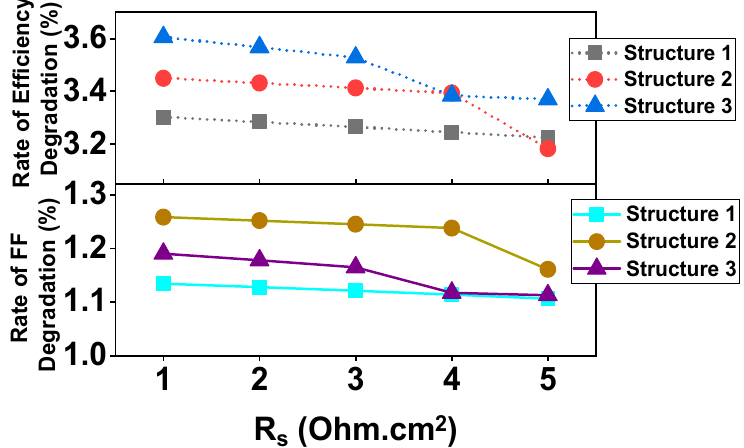
Figure 8. The rate of change of FF and PCE with respect to series resistances (Rs).